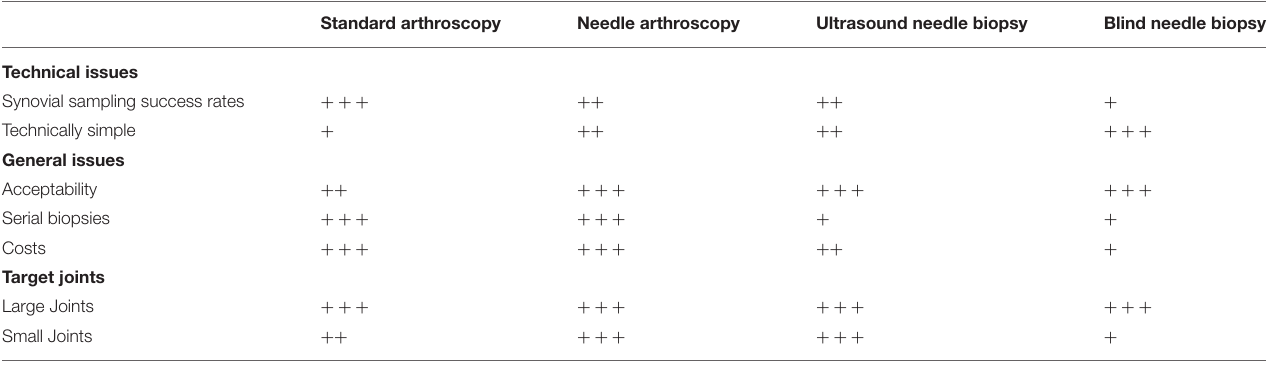
TABLE 4 | Characteristics of the different techniques used for obtaining a synovial sampling from different